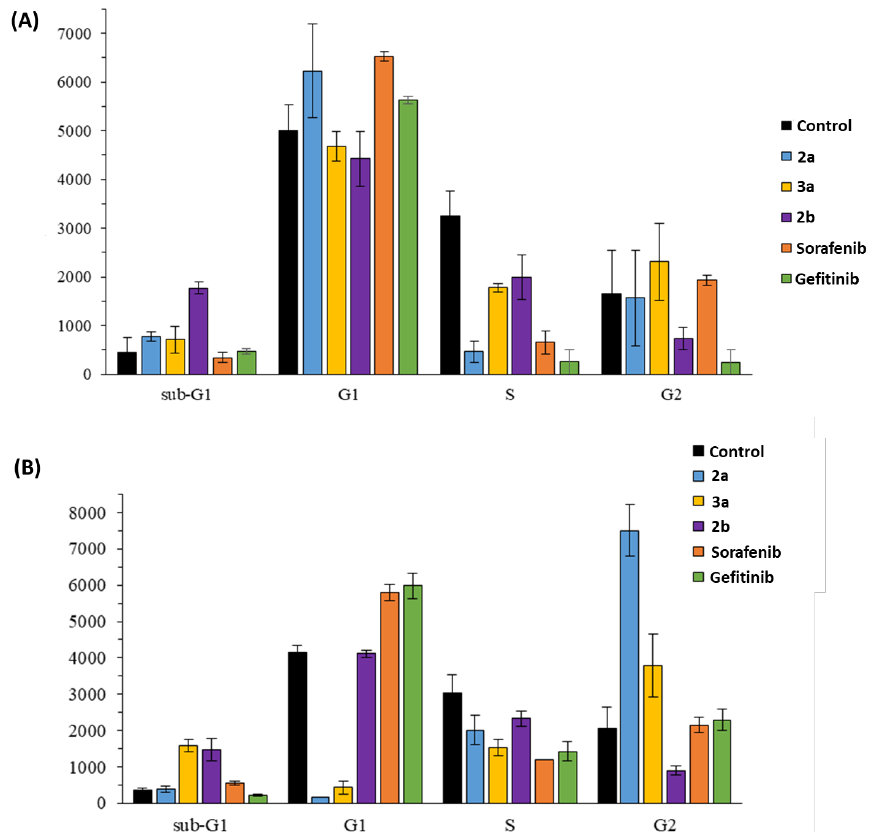
Figure 2. Effects of 2a , 2b and 3a (IC 50 concentrations) on the cell cycle of HCT-116 wildtype ( A ); and p53-knockout cells ( B ) after 24 h. Sorafenib (IC 50 ) and gefitinib (50 μ M for HCT-116 wildtype and IC 50 for p53-knockout cells) were used as positive controls. y-axis: number of cells. n = 2 ± SD. DNA binding is a possible mode of action of acrylonitriles and dichloridoruthe- nium(II) complexes. The cell-free ethidium bromide intercalation assay was applied in order to identify (salmon) DNA binding by compounds 2a , 2b and 3a . While 2a and 2b exhibited no DNA binding, the ruthenium complex 3a showed a strong DNA interaction, which was stronger than the DNA binding by the known DNA-damaging anticancer drug cisplatin (Figure 3).